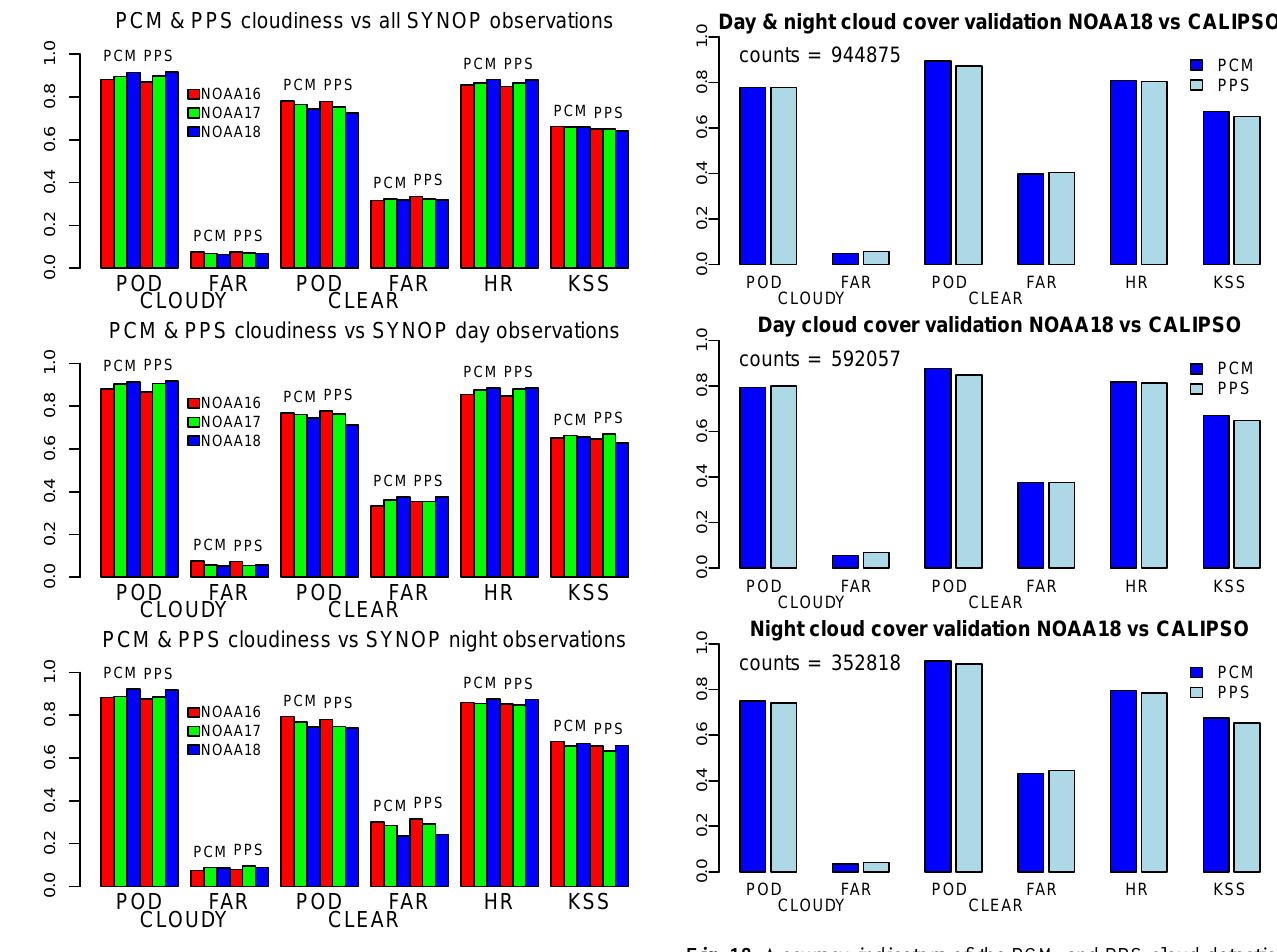
Fig. 17. Accuracy indicators of the PCM and PPS cloud detection skills derived from the comparison with SYNOP cloud observa- tions. For details see Sect. 4.3.